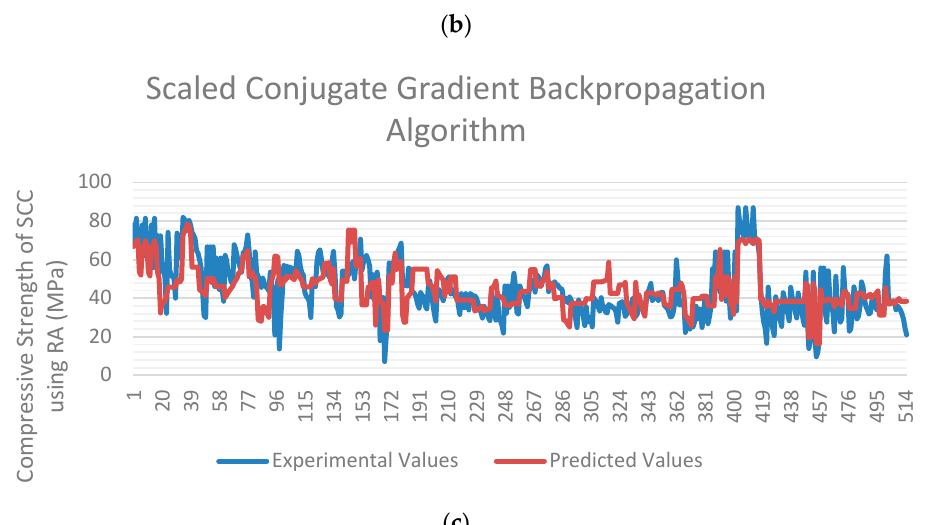
Figure 20. Comparison of compressive strength’s experimental and predicted values by different